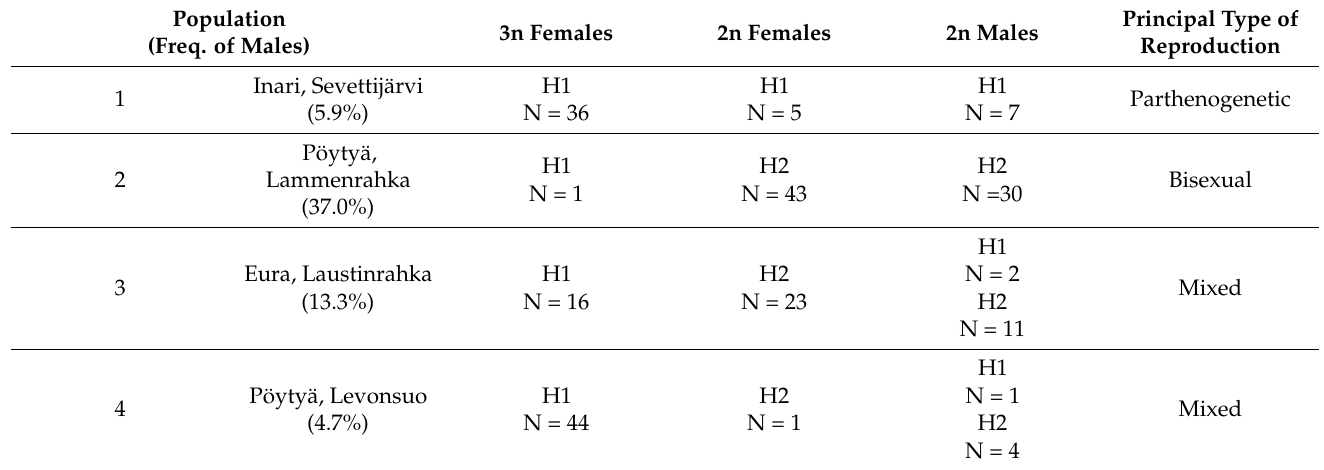
Table 2. Distribution of haplotype H1 (191T) and haplotype H2 (191A) in cytologically studied Cacopsylla ledi